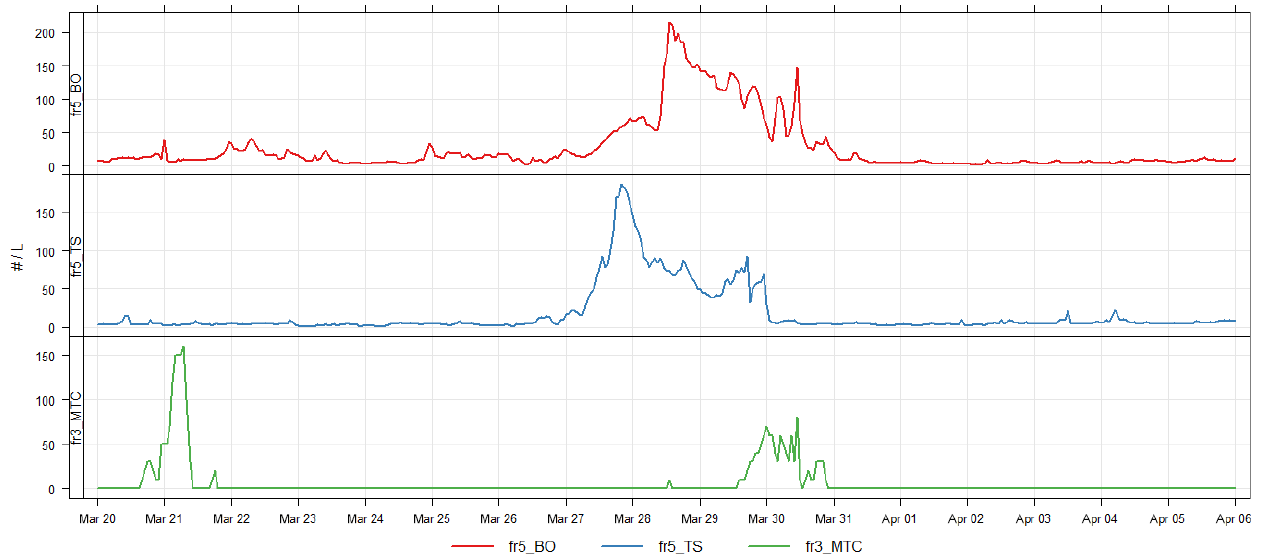
Figure 4. Temporal trends of fr5 (5.0 to 10.0µm) at Bologna (red line) and Trieste (blue line) and of fr3 (3.0 to 5.0µm) at Mt. Cimone (green line). Values are in counts per cubic decimeter (no.L − 1